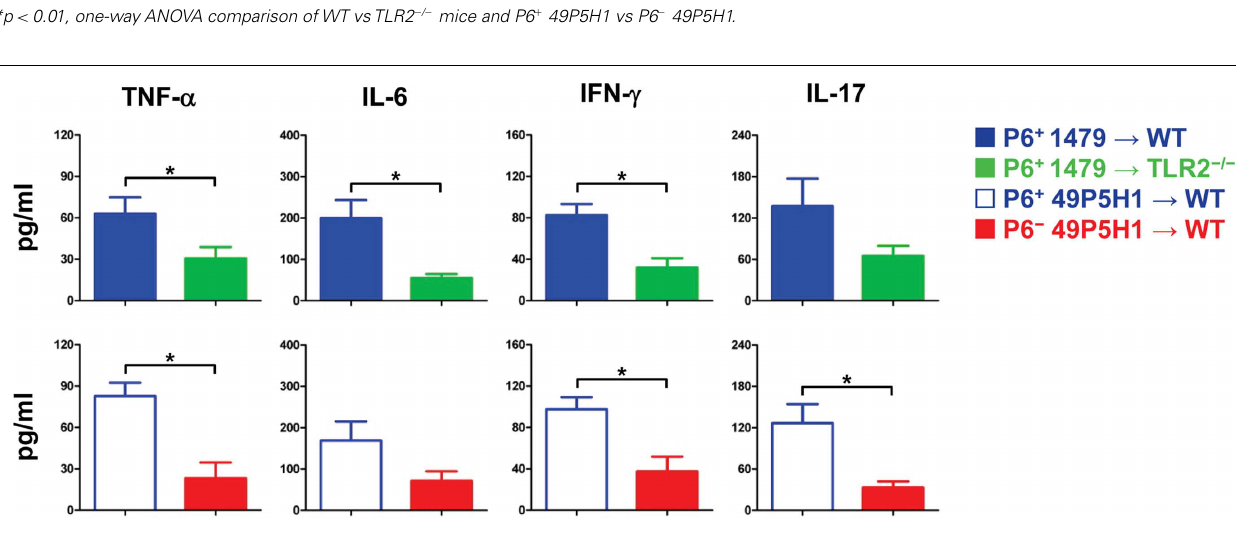
FIGURE 2 | Pro-inflammatory cytokine levels in BAL fluid. Concentration ofTNF- α , IL-6, IFN- γ , IL-17 in BAL fluid of mice exposed to either P6 + 1479